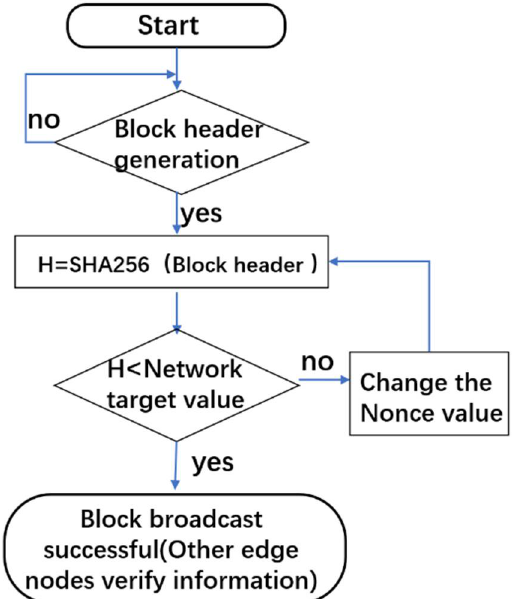
Figure 3. Flow chart of data consistency between edge nodes.